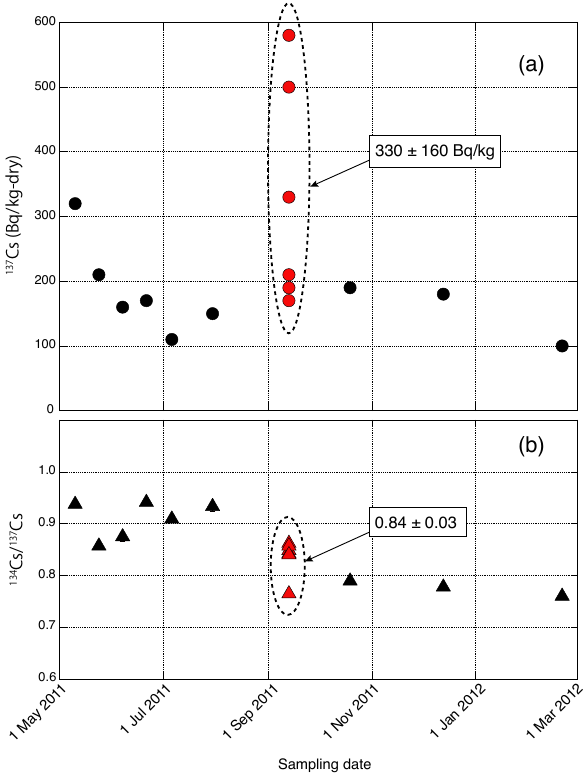
Fig. 5. (a) Temporal variation of 137 Cs concentrations in sediment samples collected at Stn. D1 (black circles) and reproducibility as indicated by data for six samples collected on 13 September 2011 (red circles). For each data point, the error is less than or equal to the size of the circle. (b) Temporal variation of 134 Cs/ 137 Cs in sediment samples collected at Stn. D1 (black triangles) and re- producibility as indicated by data for six samples collected on 13 September 2011 (red triangles). For each data point, the error is less than or equal to the size of the